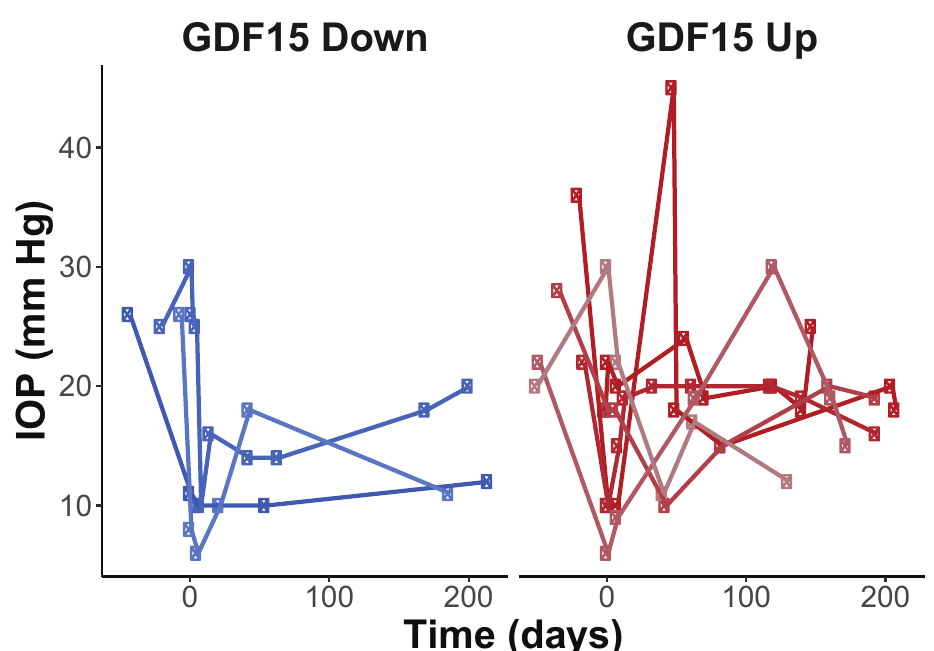
Figure 2. Serial intraocular pressure measurements by Goldmann Applanation Tonometry for participants whose aqueous humor (AH) Growth Differentiation Factor 15 (GDF15) increased (“GDF15 Up”; N = 6; shades of red) and those whose AH GDF15 decreased (“GDF15 Down”; N = 3; shades of blue). Day 0 was set as the day of glaucoma surgery when the initial AH sample was collected. Circles denote patients who received the Ahmed® glaucoma valve; squares denote patients who received the Molteno® glaucoma